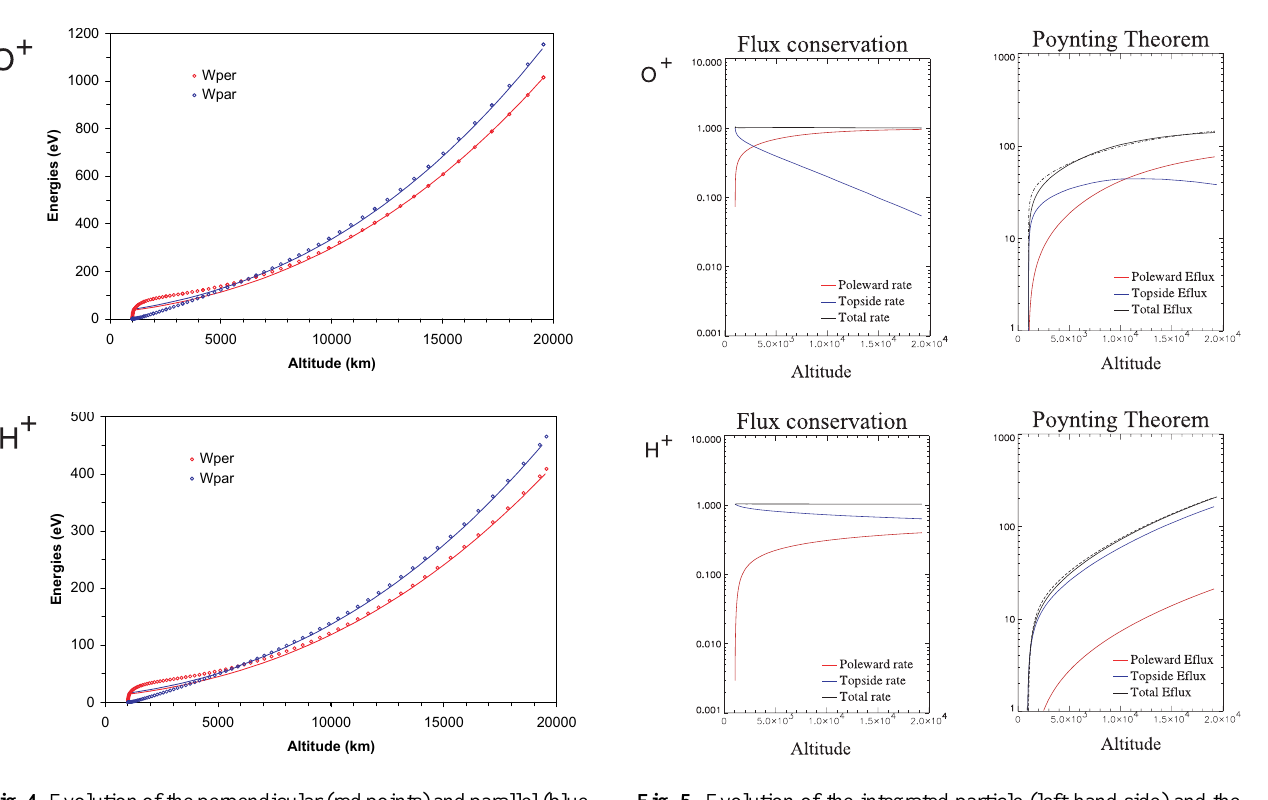
Fig. 4. Evolution of the perpendicular (red points) and parallel (blue points) energies of O + (top) and H + (bottom) test particles inside the heating region as a function of altitude. The corresponding solid curves are inferred from the mean ion theory of Chang et al. (1986).